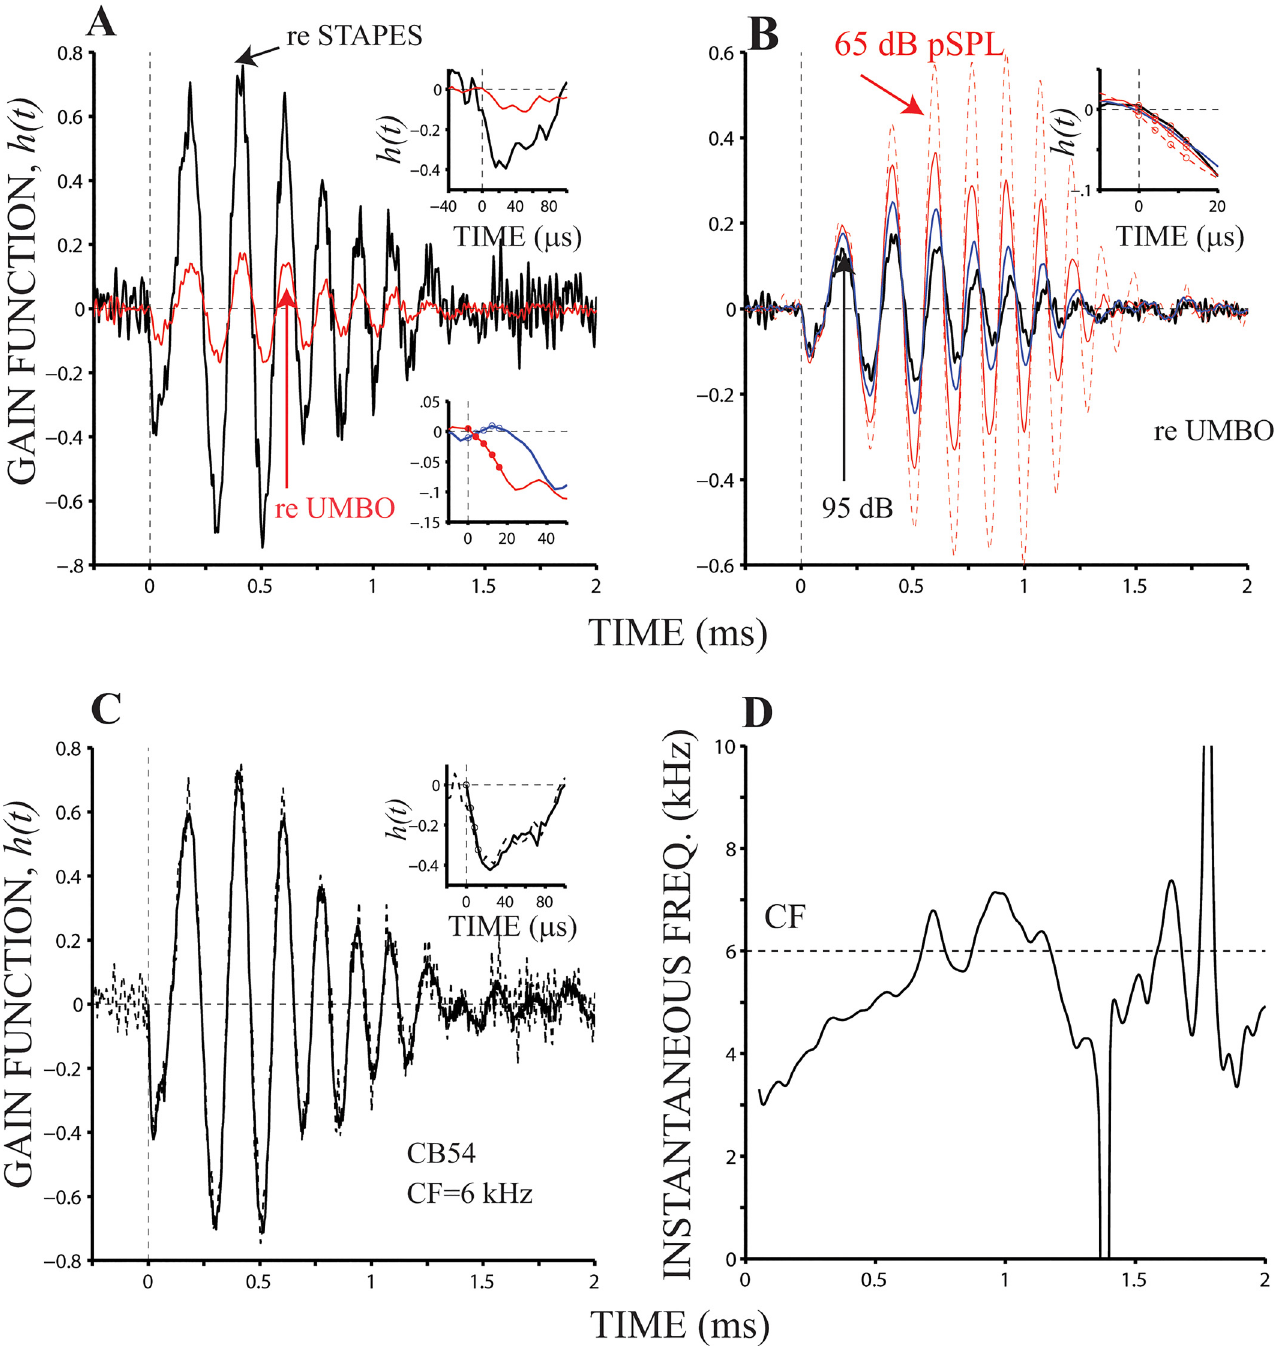
Fig 4. Instantaneous gain functions. Panel (A) displays h ( t ) functions obtained from middle ear (stapes or umbo) and BM responses to 95-dB pSPL clicks. The thickest lines in (B) were computed from responses to 95-dB pSPL clicks (the waveform is the same plotted in panel (A)); the remaining lines from responses to 85-, 75- and 65-dB pSPL clicks. All the traces in panel (B) were obtained using the umbo response as input. Upper insets in (A) and (B) show the initial part of the h ( t ) functions displayed in the main panels. Symbols in the inset in panel (B) represent the four initial samples of the gain functions. Panel (C) displays one h ( t ) function (black line) from panel (A) (95-dB pSPL) as well as a synthetized version (gray line) of it (see Eq 2 in Methods section). The blue line with symbols in the lower inset in panel (A) represents h ( t ) function evaluated after delaying the input waveform by 5 samples (see main text). The red line with symbols in the same inset is the same as the one shown in the upper inset (same color). Panel (D) exhibits the instantaneous frequency representation of the gain function in panel (A) (red